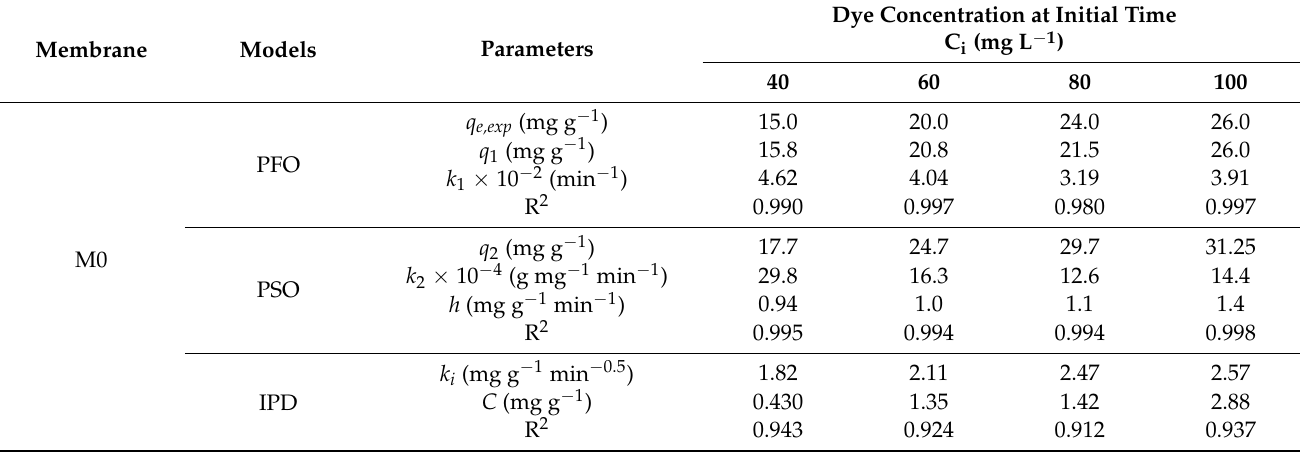
Table 3. Parameters calculated from the PFO, PSO and IPD models for the adsorption of hydRB5 in the nanocomposite membranes in pH~7 and 25 ± 0.5 ◦